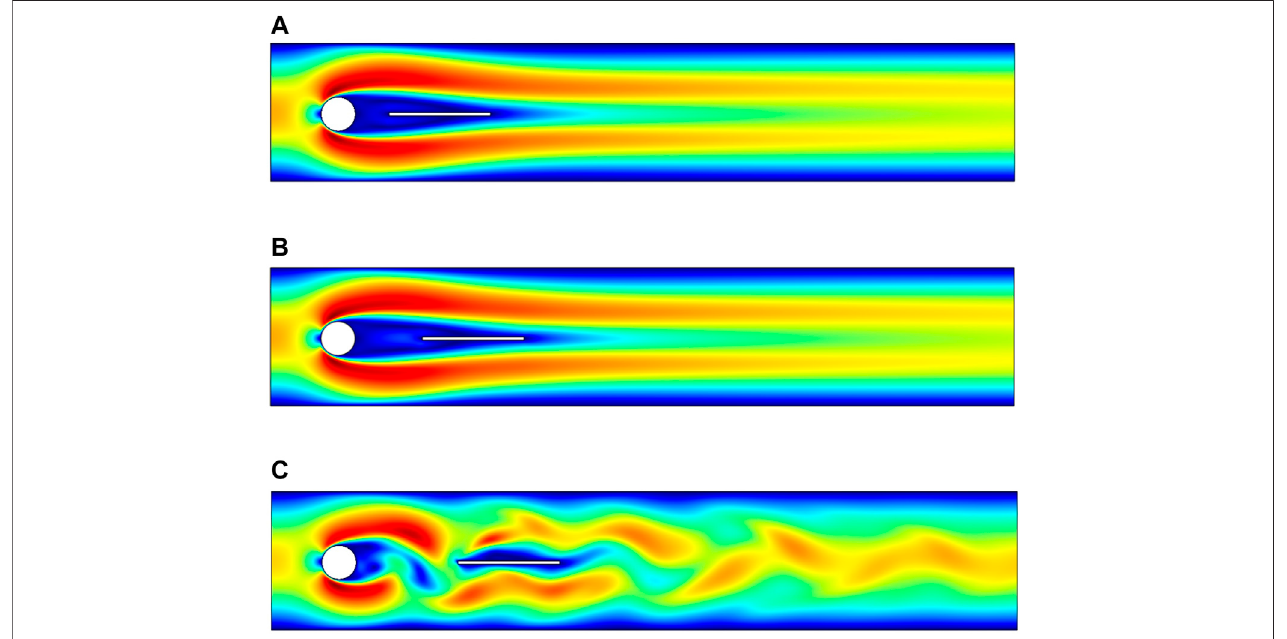
FIGURE 6 | In fl uence of splitter plate with various gap separation on velocity, placed at gaps (A) G 1 = 0.1 , (B) G 2 = 0.2 , (C) G 3 = 0.3 with Re (cid:1) 100 at (cid:2) t (cid:1) 10 .